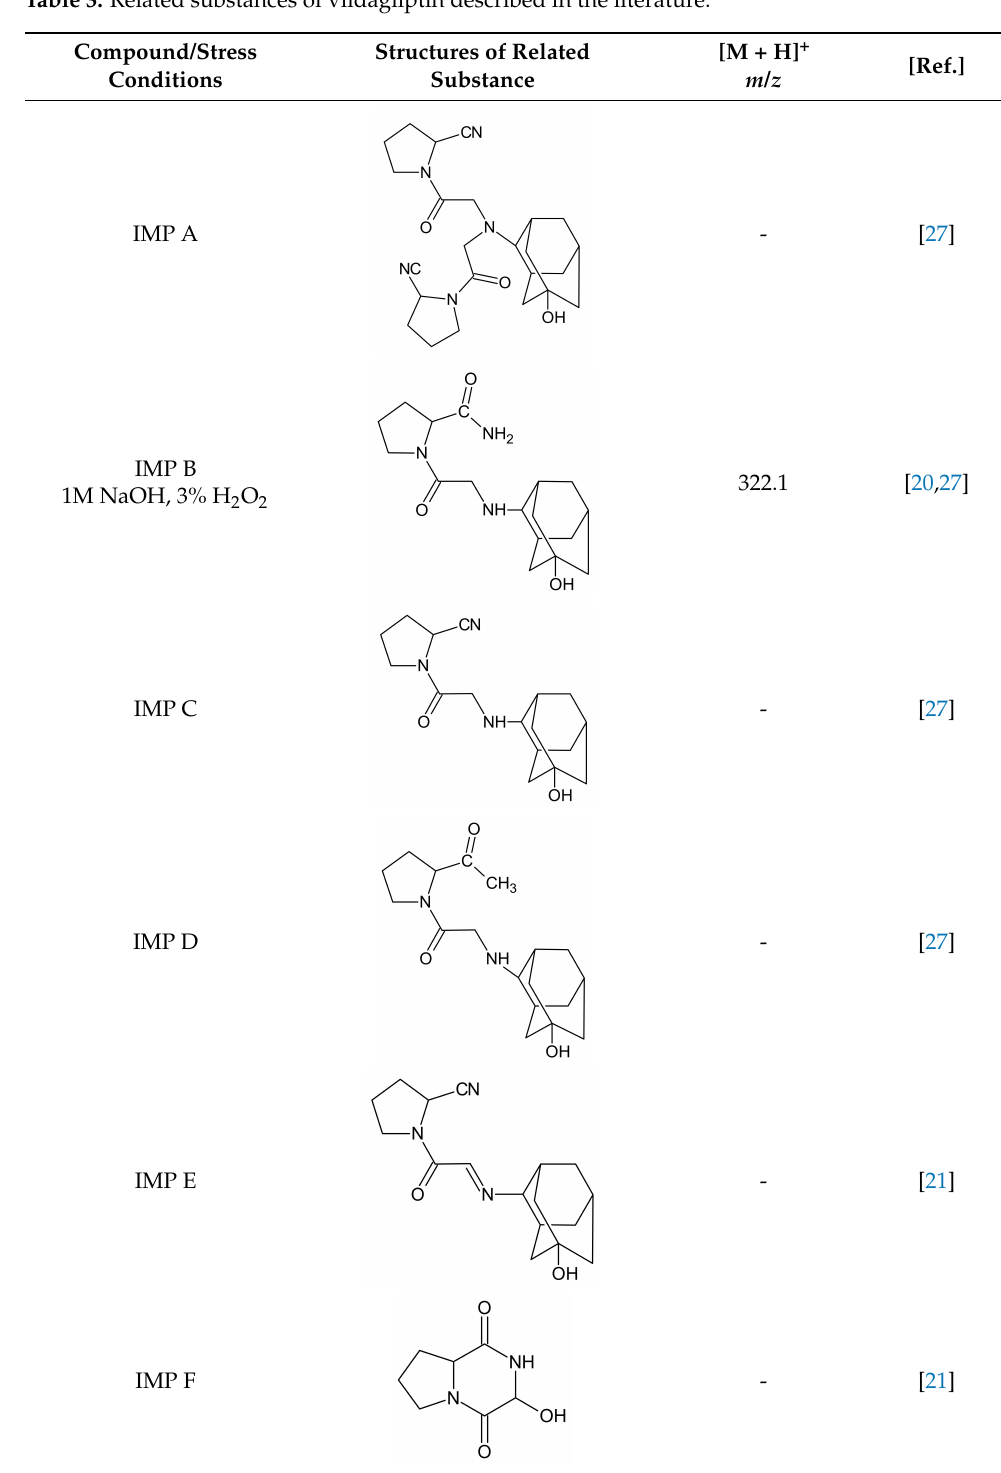
Table 3. Related substances of vildagliptin described in the